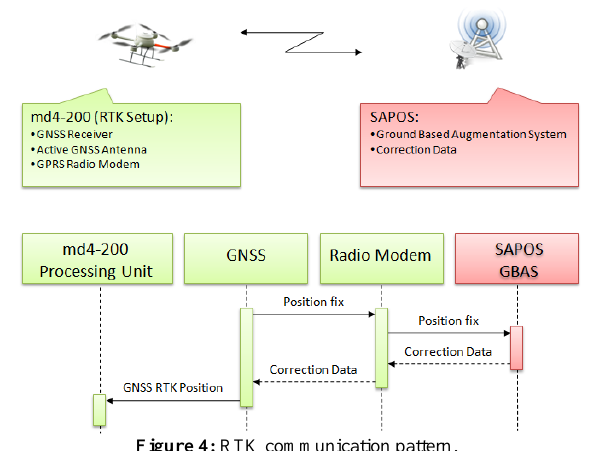
Figure 4: RTK communication pattern.